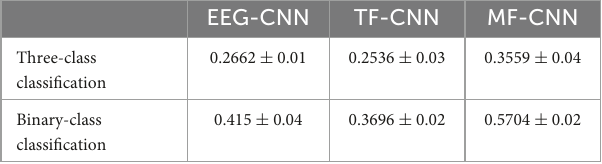
TABLE 1 Kappa values of the three deep learning